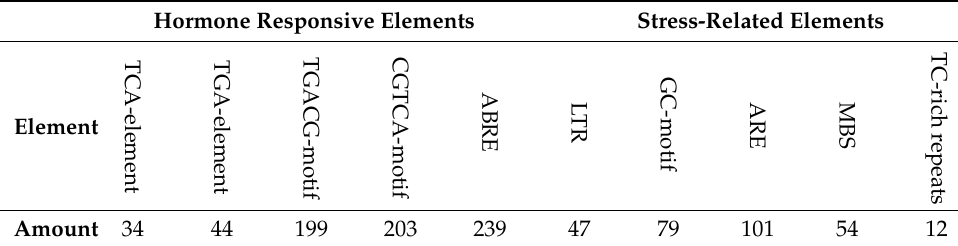
Table 4. Cis-acting elements analysis of TaGATAs.